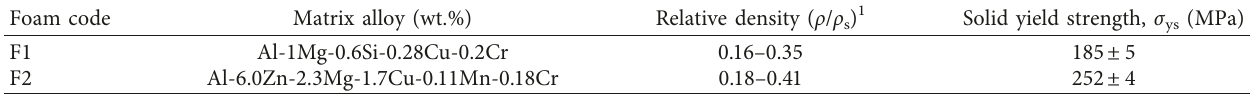
Table 2: Characteristics for Al foams and